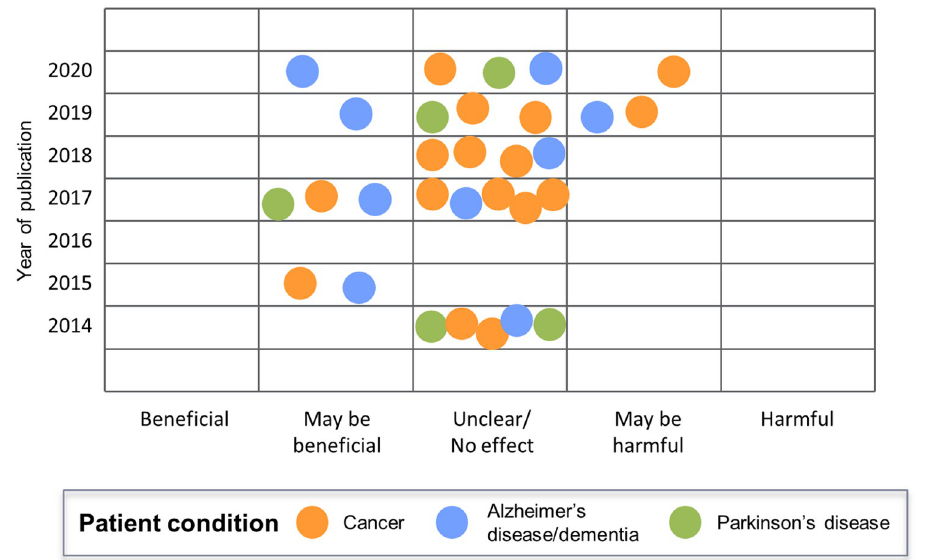
Fig 6. Overall conclusions in systematic reviews regarding the use of cannabis in specific patient conditions, by year of publication.